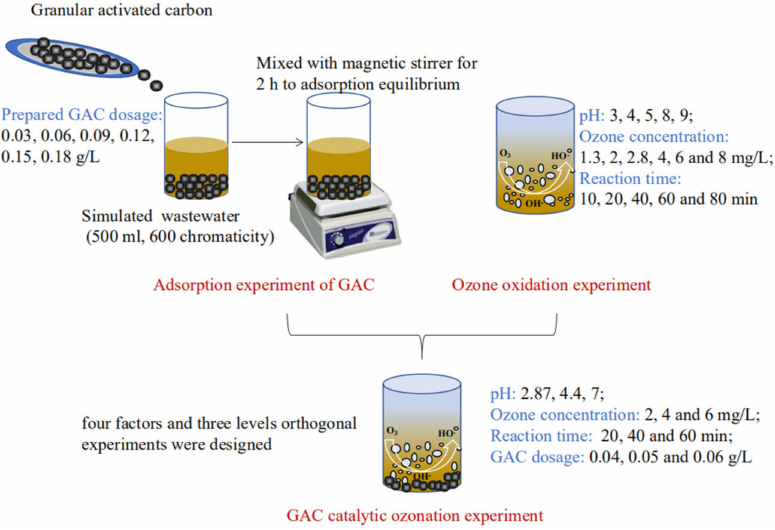
Figure 2. Flow chart diagram for experimental procedure design.